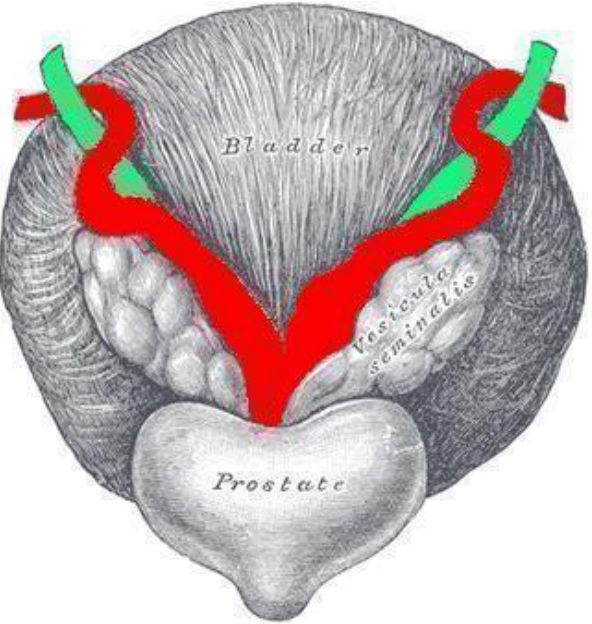
FIGURE 7. Diagrammatic representation of the crossover of the ureter (shaded green in this figure) by the vas deferens (shaded red in the above